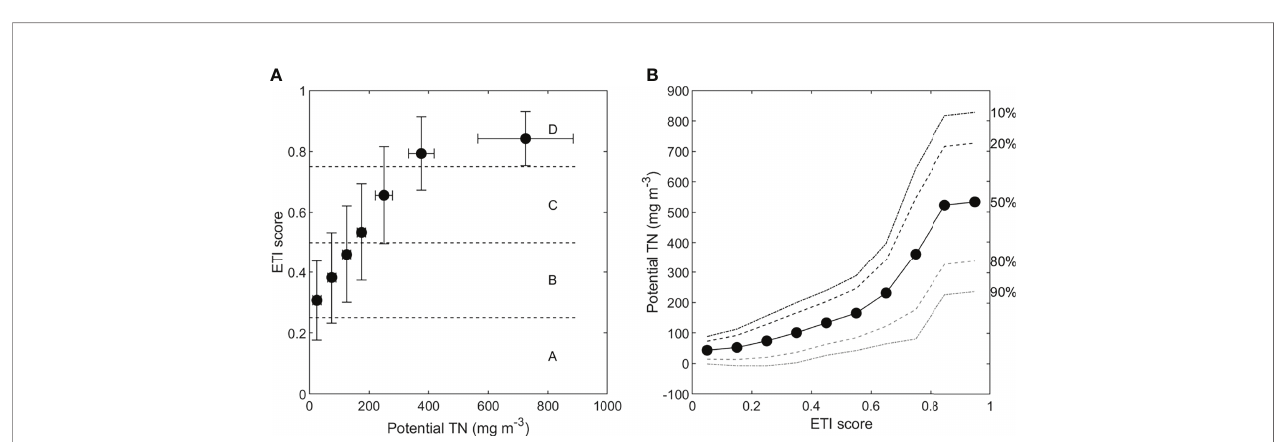
FIGURE 9 | (A) Predicted ETI Tool 3 BBN score with increasing potential TN concentration in Jacobs River Estuary. Error bars show the standard deviation of the predicted BBN score and the potential TN concentration based on the TN band width. (B) Potential TN concentrations predicted by specifying a desired ETI score. The lines show the probability that the desired ETI score (or lower) will be obtained by a potential TN concentration, where lower ETI scores mean less